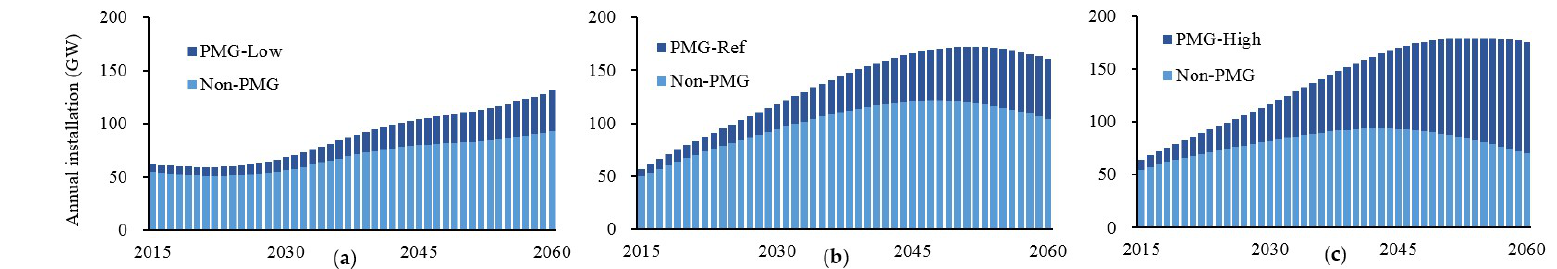
Figure 5. Annual Wind power installation. ( a ) RTS ( b ) 2DS ( c ) B2DS.